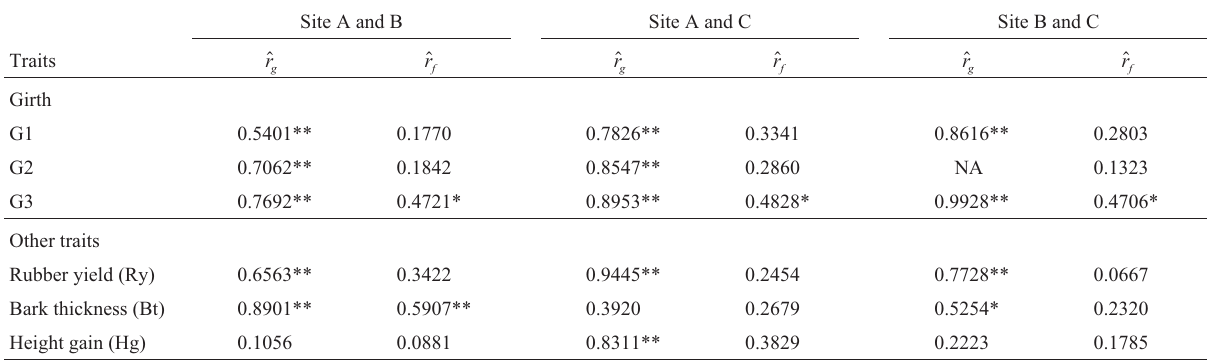
across sites, genetic correlations were slightly greater than the corresponding phenotypic correlations (Table 6). At in- dividual sites and across sites, genetic and phenotypic cor- relations between increased girth and rubber yield were between (cid:1) r = 0.15 and (cid:1) r = 0.92 with few exceptions, genetic correlations between girth and rubber yield being greater than the corresponding phenotypic correlations (Table 6). At site A, bark thickness was positively genetically corre- lated with girth ( (cid:1) r = 0.60 to (cid:1) r = 0.71) and rubber yield Axy Axy (cid:3) 020 . The phenotypic correlations for bark thickness ) r Axy with girth and rubber yield at this site were also positive but weak. Across sites, rubber yield did not correlate geneti- cally or phenotypically with girth, bark thickness or height gain. Table5 -GeneticandPearson’scorrelationcoefficientsbetweensitesforsix Hevea traitsin22open-pollinatedprogeniesof Hevea growingatthreesites (Votuporanga (A), Pindorama (B) and Jaú (C)) in the Brazilian state of São Paulo. Girth measured when the trees were one (G1), two (G2) and three (G3) years old. Site A and B Site A and C Site B and C